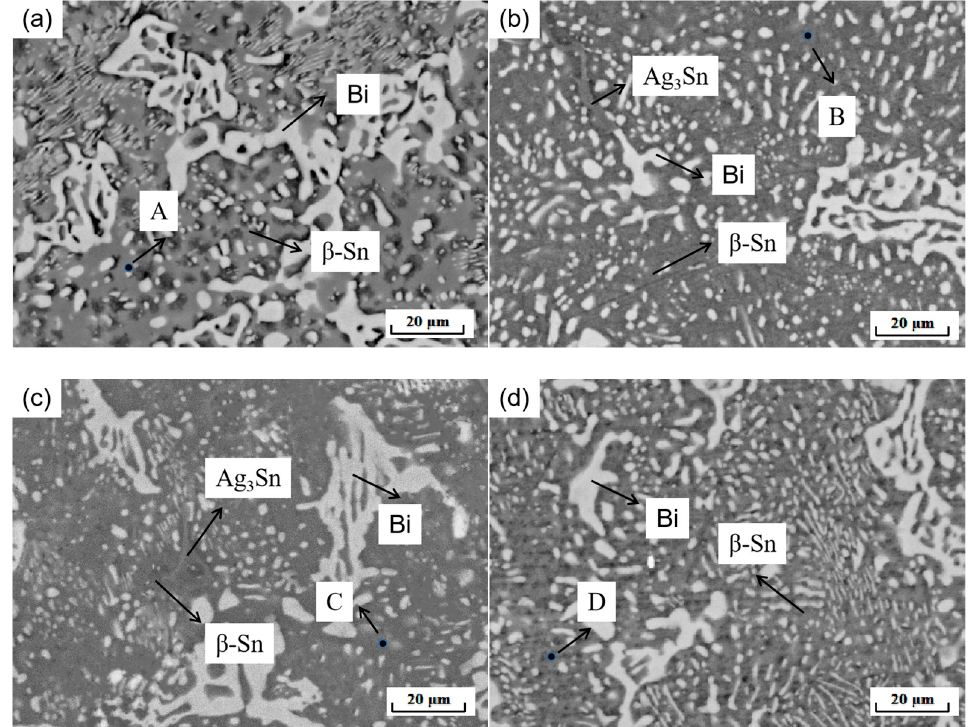
Figure 6. Microstructure of SnBiAg–xIn (x = 0, 0.5, 1, 1.5) alloy solder: ( a ) SnBiAg; ( b ) SnBiAg0.5In; ( c ) SnBiAg1.0In; ( d ) SnBiAg1.5In.